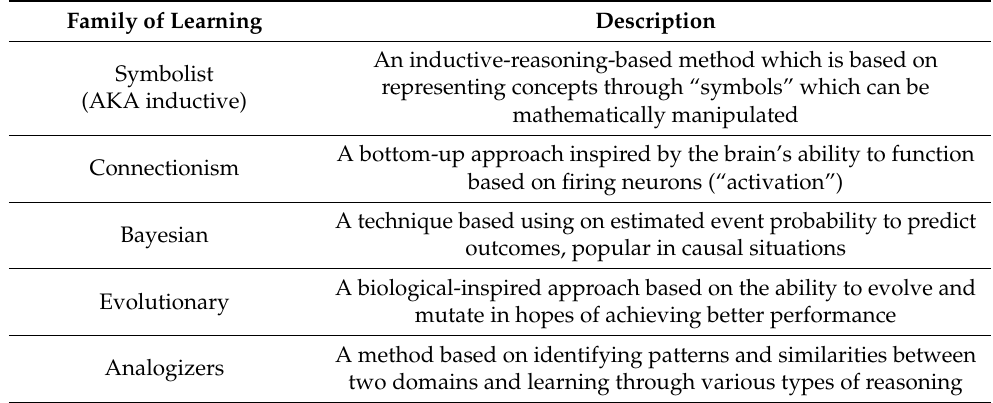
Table 1. Summary of Domingos’s ML algorithm family definitions (see [11] for